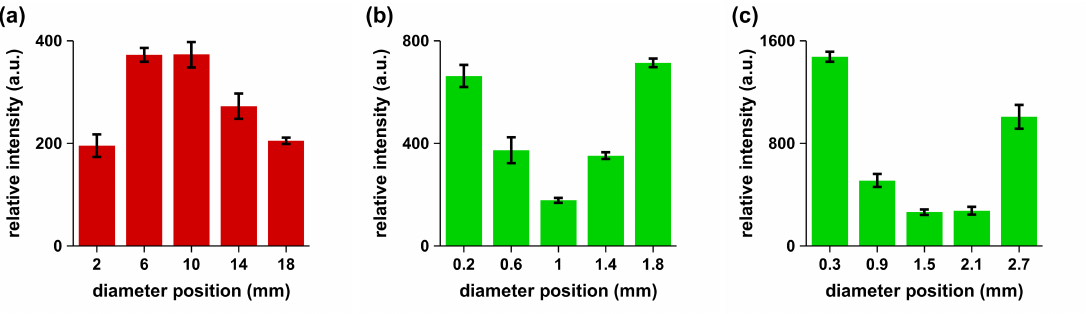
Figure 3. Trends of the measured signals of Mg I 280.2 nm along cross-sections: ( a ) 20-mm non-granular gallstone; ( b ) 2-mm; and ( c ) 3-mm granules of granular